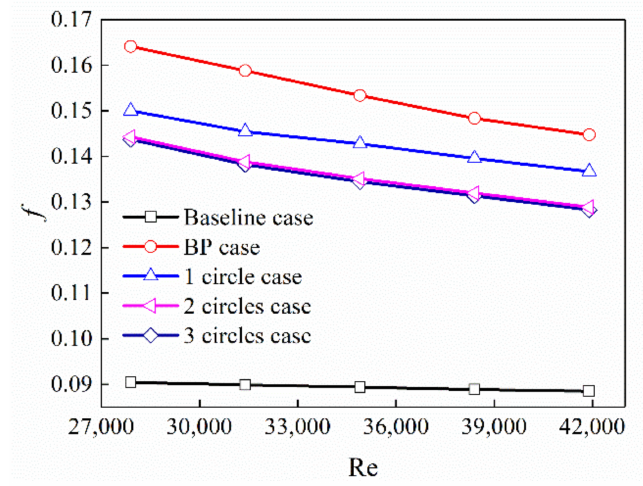
Figure 14. Variation of friction factor with Re.